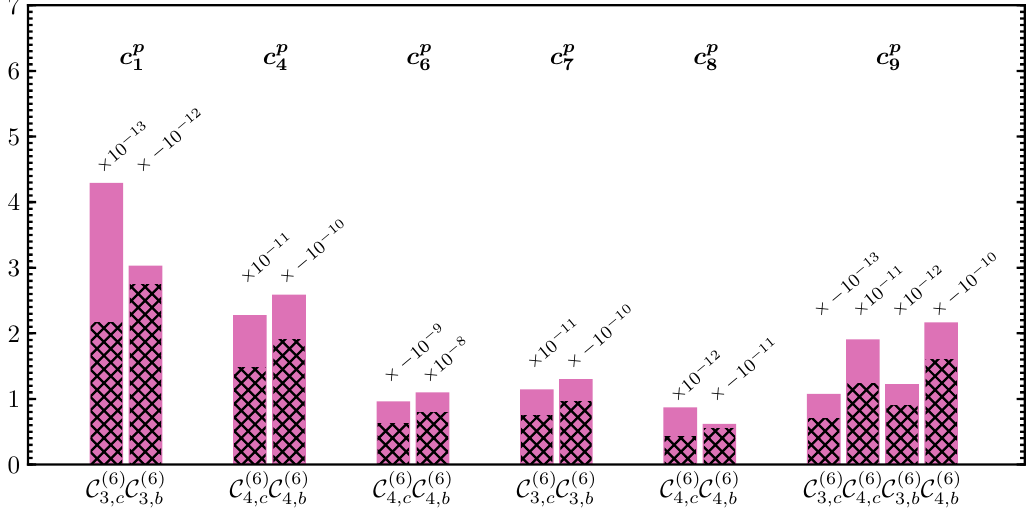
, eqs. (5.5){(5.10), controlling i